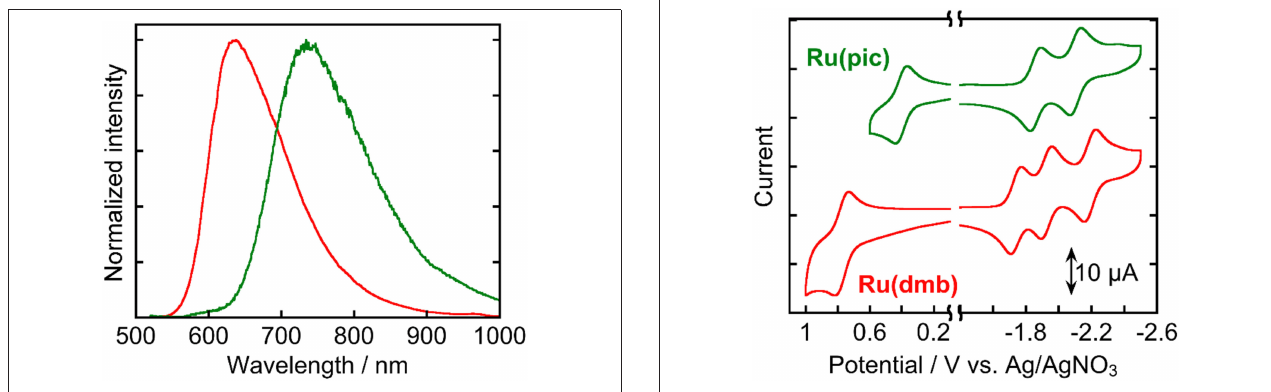
FIGURE 2 | Normalized emission spectra of Ru(pic) (green line) and Ru(dmb) (red line) measured in a DMA solution. The excitation wavelength was 480nm.